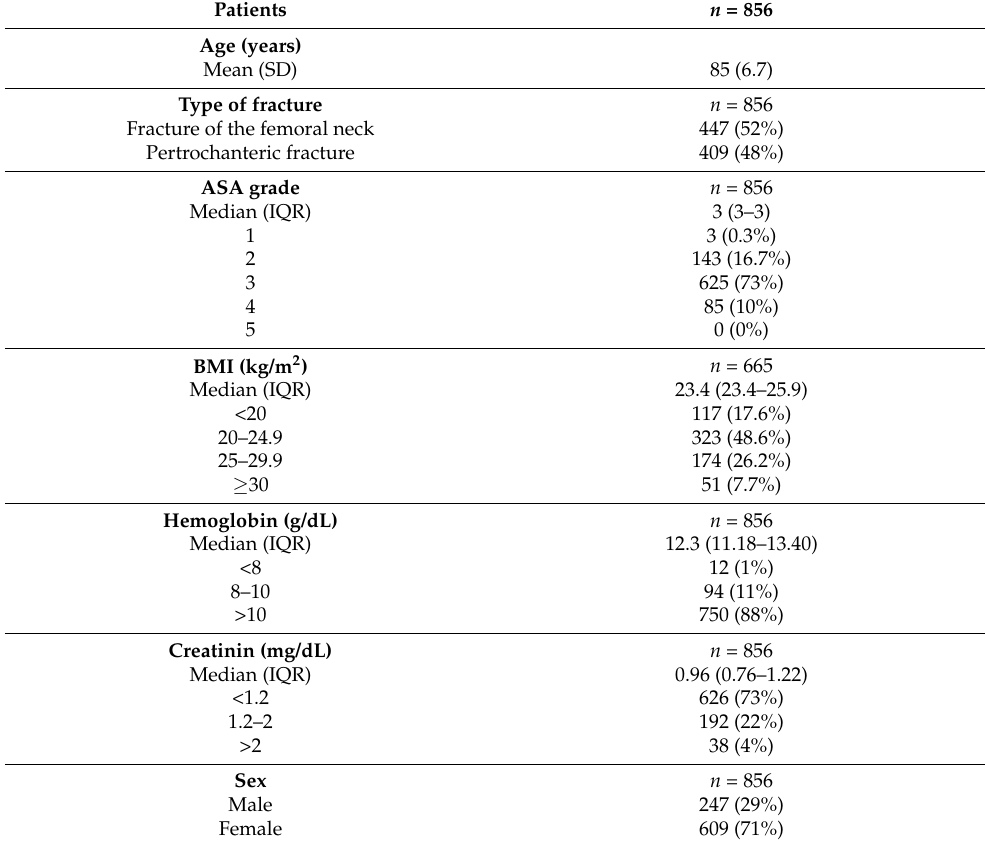
Table 1. Baseline data. The number of patients with data is given separately for each parameter. SD, standard deviation; ASA grade, American Society of Anesthesiologists; ISAR, Identification of Seniors At Risk; IQR, interquartile range; BMI, body mass index; mg, milligram; g, gram; kg, kilogram; m, meter; dl, deciliter; CCI, Charlson Comorbidity